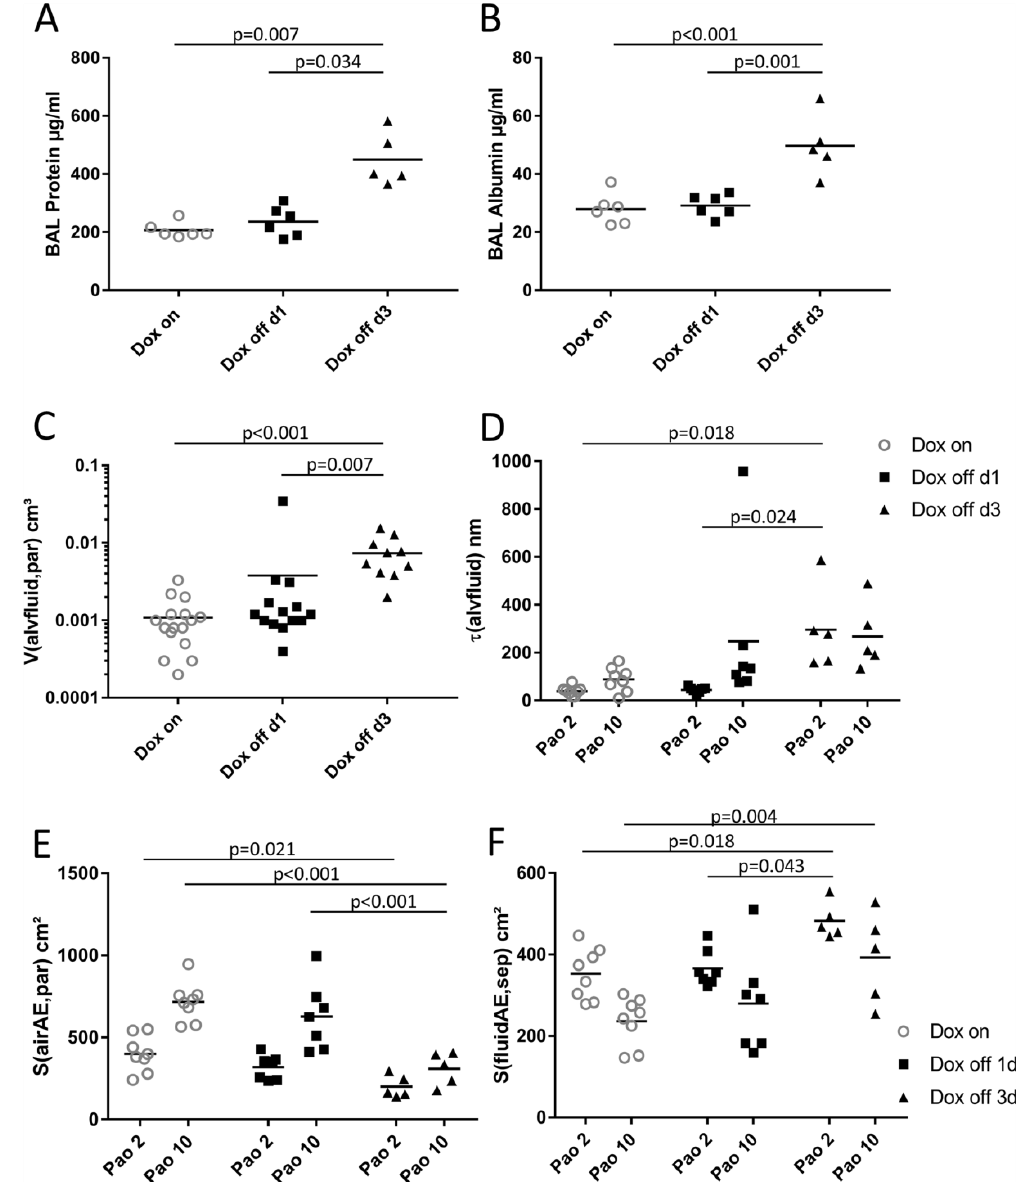
Figure 5. Properties of alveolar fluid. BAL was assessed regarding protein ( A ) and albumin ( B ) concentration. In addition, alveolar fluid was characterized by stereological parameters as follows: Total volume of alveolar fluid per lung ( C ) V(alvfluid,par), arithmetic mean thickness of alveolar fluid ( D ) τ(alvfluid), the surface area of alveolar epithelium covered by air ( E ) S(airAE,par) or covered by alveolar fluid ( F ) S(fluidAE,sep). Table 3. Alveolar fluid.